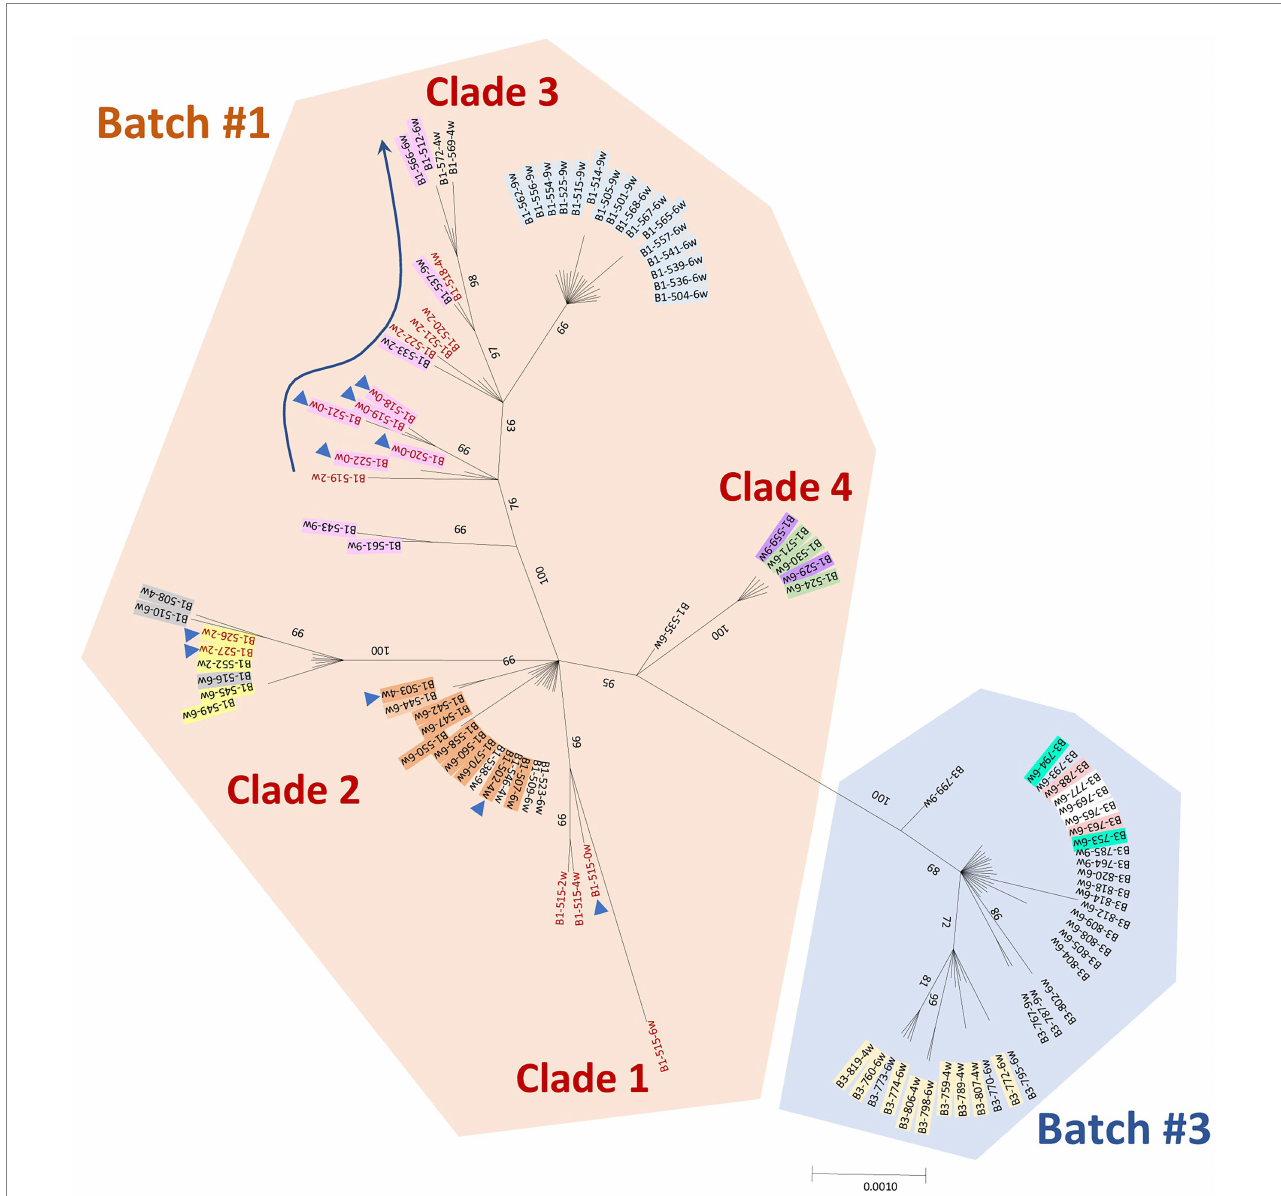
FIGURE 3 Bayesian phylogenetic tree based on the nucleotide sequences of PRRSV-1 ORF5 (gene size of 606 bp) using MrBayes (1,000,000 iterations). ORF5 sequences obtained from born-infected animals with long viremias (in red) and the new infection cases (in black) are included. The orange and blue shaded areas correspond to sequences retrieved from Batch 1 and 3, respectively. Sequences from vertical transmission events are marked with a blue triangle. The shaded sequences with the same color correspond to animals belonging to a transmission chain. Only posterior probability values >70% are